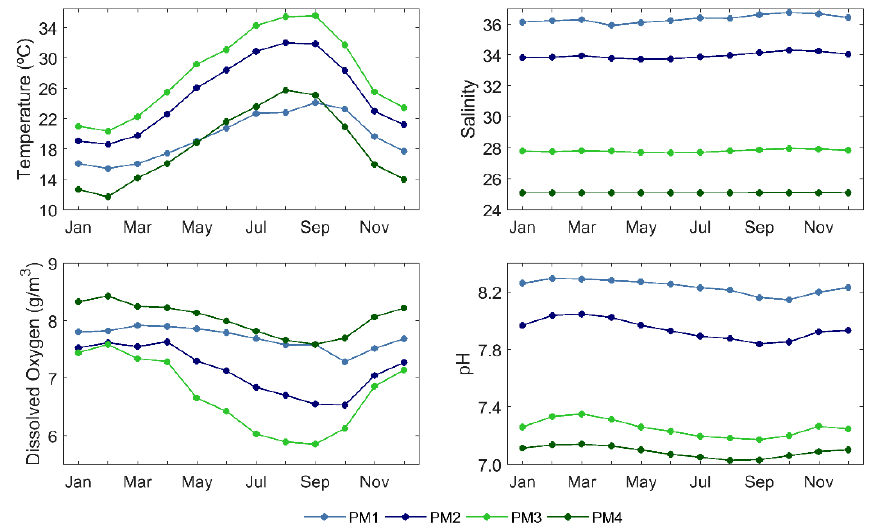
Figure 7. Monthly mean of water temperature (°C), salinity, DO (g/m 3 ), and pH at four points throughout Mira Estuary (red dots in Figure 1A).